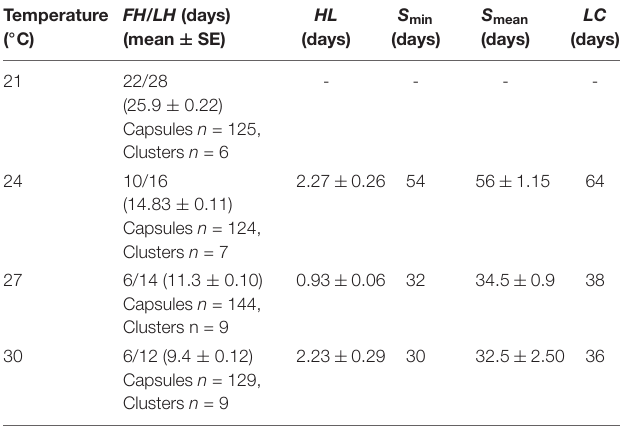
TABLE 1 | Life cycle parameter table for Prosthiostomum acroporae. Temperature ( ◦ C)